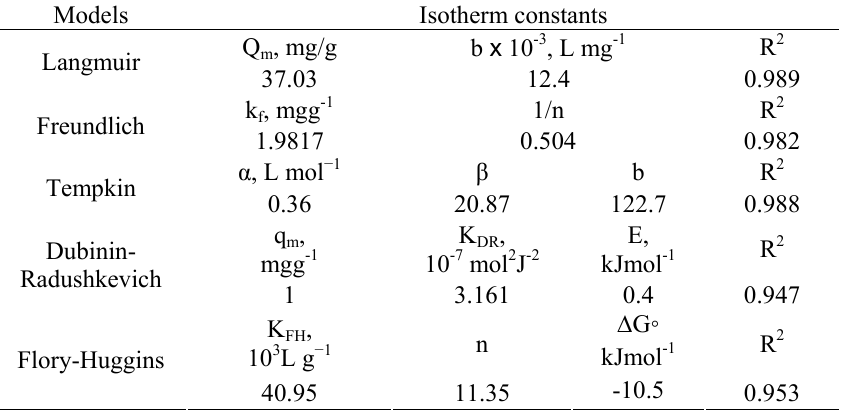
Table 1. Results of various isotherm plots for the adsorption of MG onto